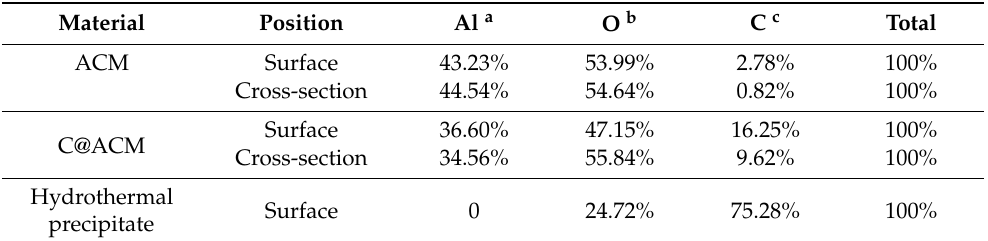
Figure 4. Characterization of ACM and C@ACM: ( a ) pore size distribution; ( b ) Raman spectra; ( c ) FT-IR spectra; ( d , e ) XPS spectra of O 1s and C 1s. Table 1. The atomic ratio of Al, O, and C from ACM, C@ACM, and hydrothermal precipitate tested by EDS